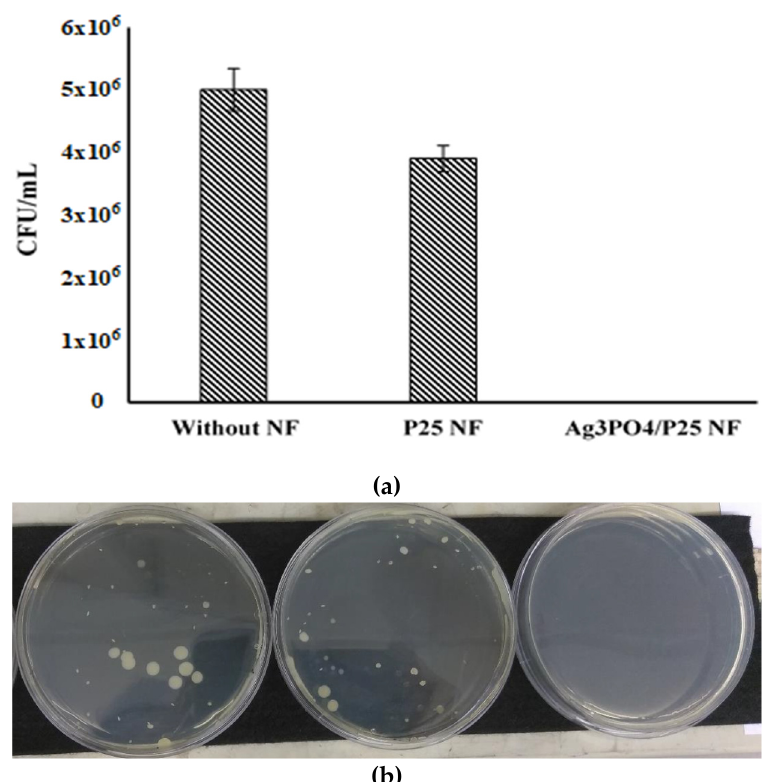
Figure 8. ( a ) and ( b ): The E. coli colonies without nanofibers and after contact with P25 and Ag 3 PO 4 / P25 nanofibers (inoculum level 10 6 CFU/mL).